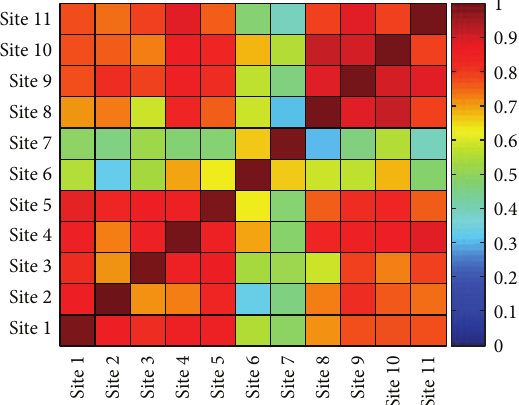
Figure 5: Correlation analysis among BTEX concentrations in all investigated